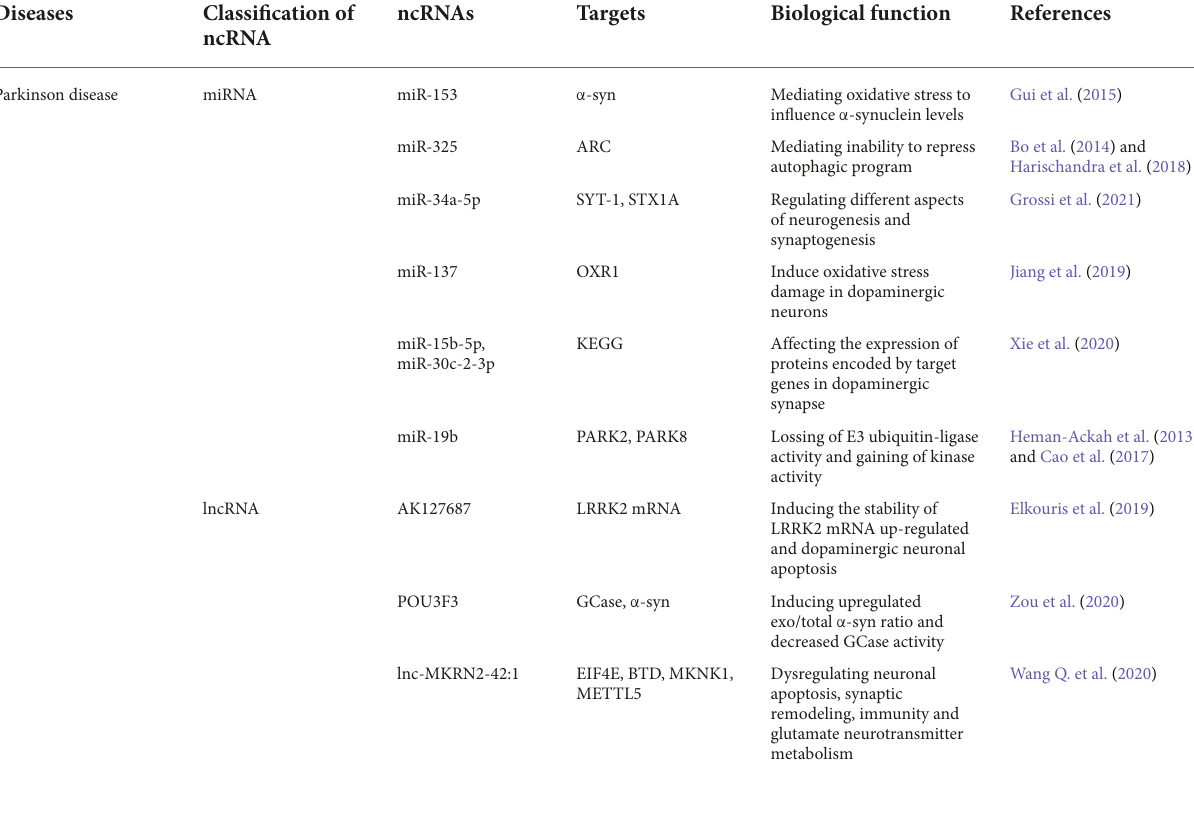
TABLE 2 The biological functions of exosomal ncRNAs in Parkinson’s